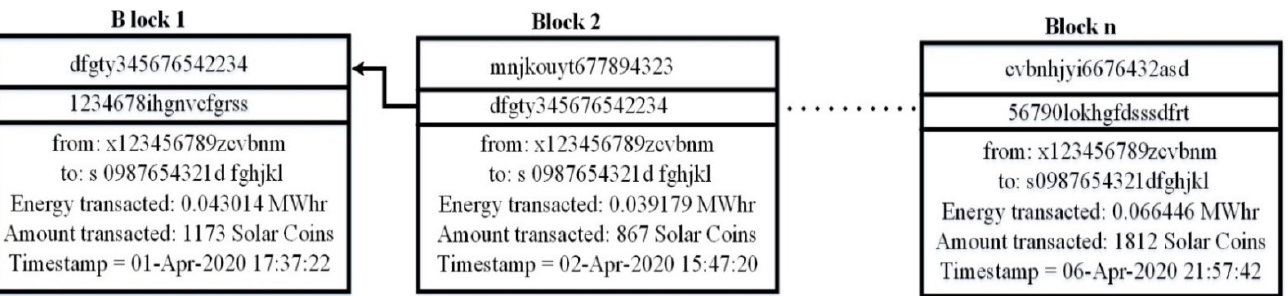
Figure 11. PES and PEC comparison. 4.4. Critical Analysis The comparative tabular analysis of unoptimized and optimized GA DSM is scruti- nized in this sub-section. Aggregate energy transactions accomplished in all four seasons are extensively analyzed. 4.4.1. Comparative Analysis of Demand Management Table 5 presents the comparative statistics of DSM performed on the proposed SLR blockchain-based METM. Unoptimized and GA-optimized results for ED1, ED2, and ED3 enveloping PEC, PES, and GR are manifested in this table. The average change observed between unoptimized and optimized results of the three EDs is analyzed. The table shows GA optimized results surpass the unoptimized results. PEC is effectively minimized throughout the year as a result of optimization of EDs’ demand. Similarly, energy surplus